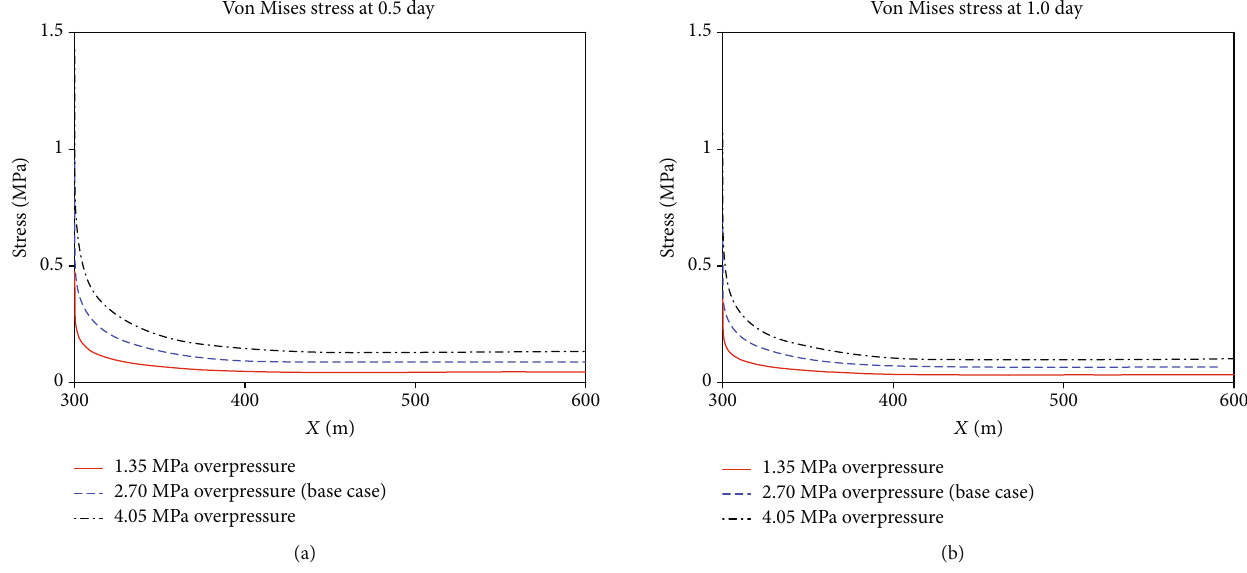
Figure 7: 1D stress distribution from the wellbore to the domain boundary along Y = 300 m after (a) 0.5 day and (b) 1 day of shallow water fl ow for overpressure